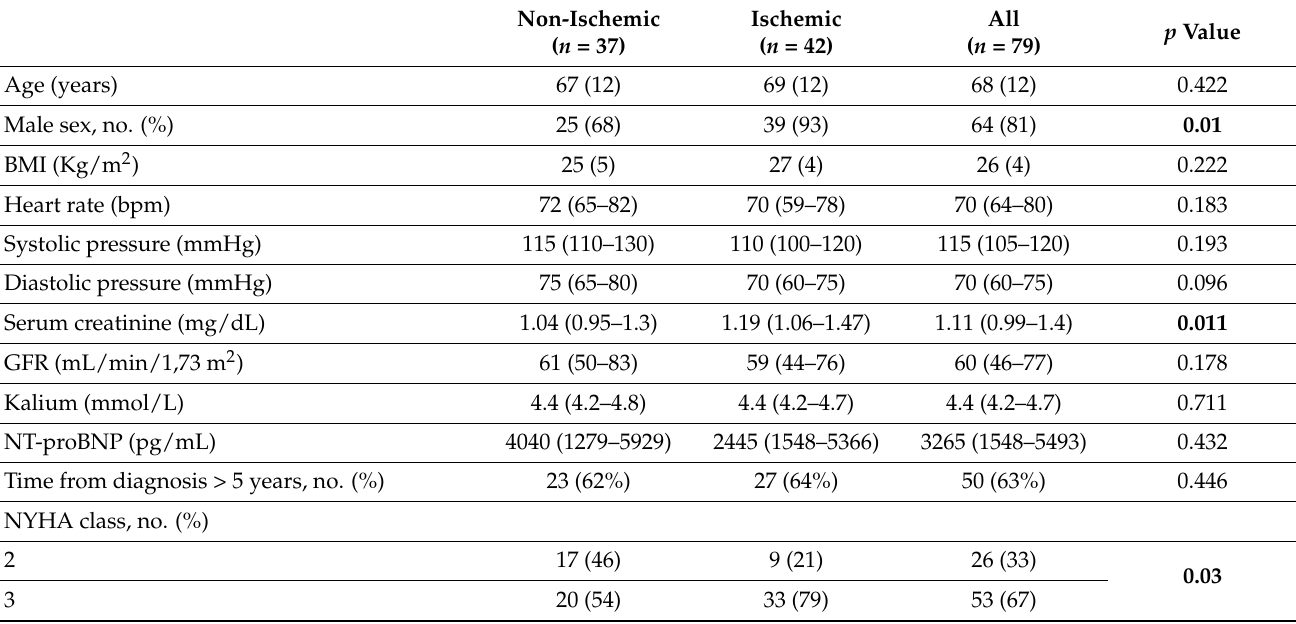
Table 1. Patient’s characteristics at baseline. Categorical variables are represented as frequencies and percentages, continuous variables as median and interquartile range or mean and standard deviation. Ischemic and non-ischemic group are compared using Fisher’s exact test; continuous variables are compared with t -test for independent data or Wilcoxon non-parametric test. BMI = body mass index, GFR = glomerular filtration rate, NT-proBNP = N-terminal pro-B-type natriuretic peptide, NYHA